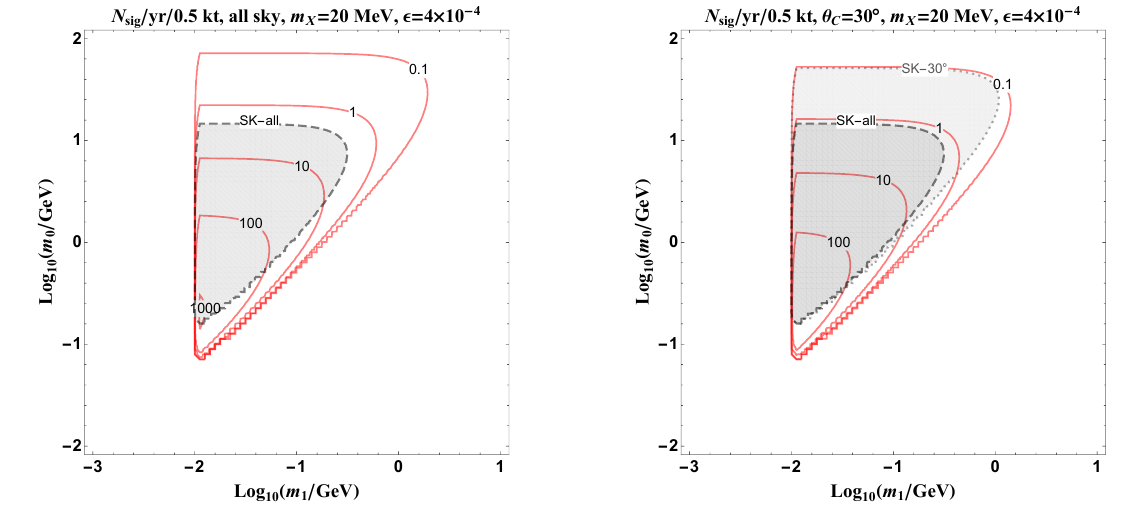
Figure 7 . The number of signal events per year for all sky (left panel) and 30 (cid:14) cone (right panel) with V (cid:12)d = 0 : 5 kt, m X = 20 MeV, and g D (cid:1) (cid:15) = 4 (cid:2) 10 (cid:0) 4 . The darker gray-shaded area represents the 90% exclusion bounds with all sky data from SK (13.6 yr) [53, 54], assuming 10% systematic uncertainty in the estimation of background number of events. The light-shaded area in the right panel represents current BDM bounds using 161.9 kt (cid:1) yr of data reported by SK [24].